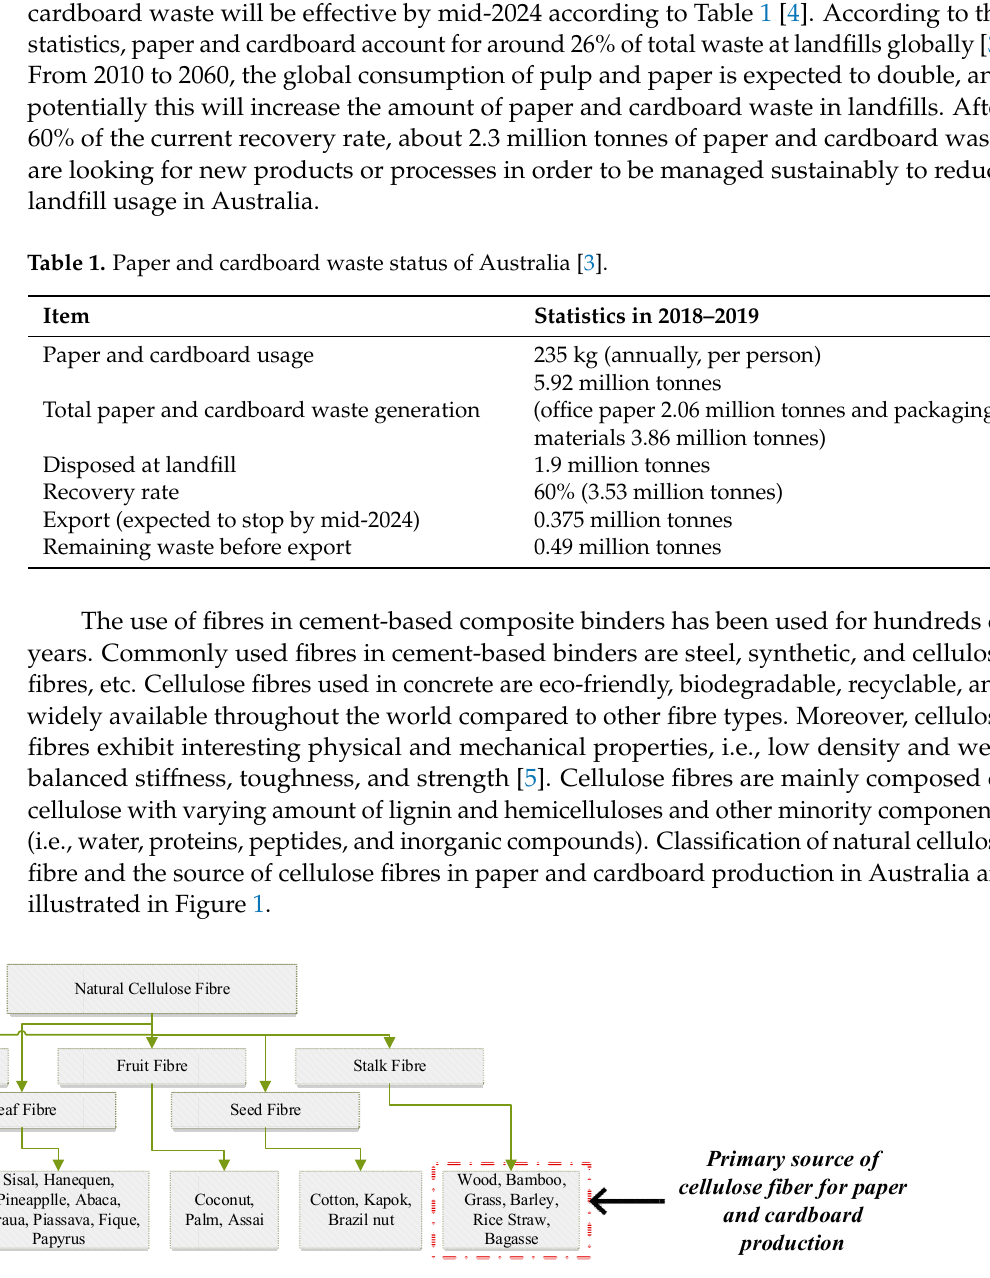
Figure 1. Classification of cellulose fibre.